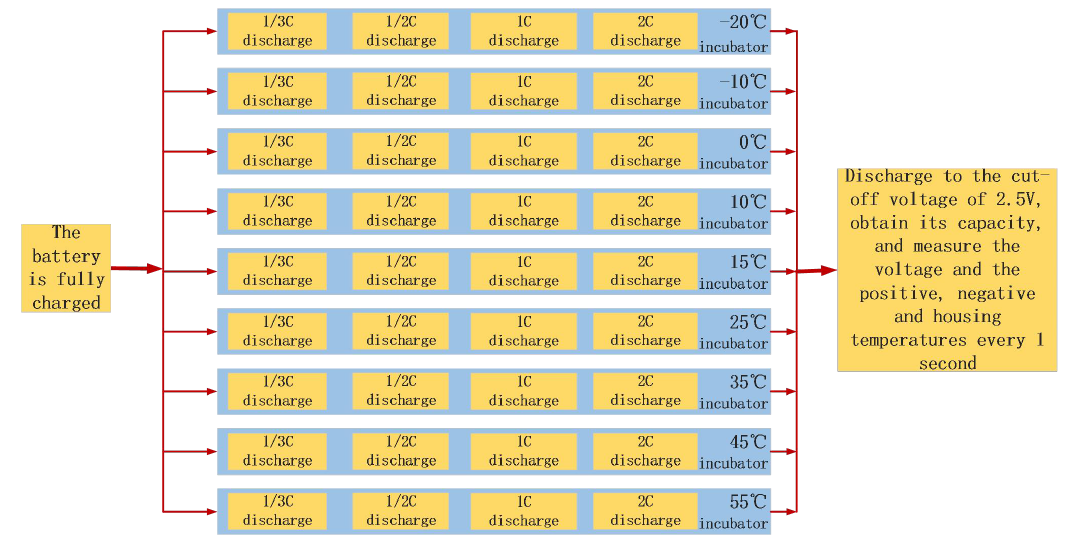
Figure 4. Schematic diagram of discharge experiment flow.